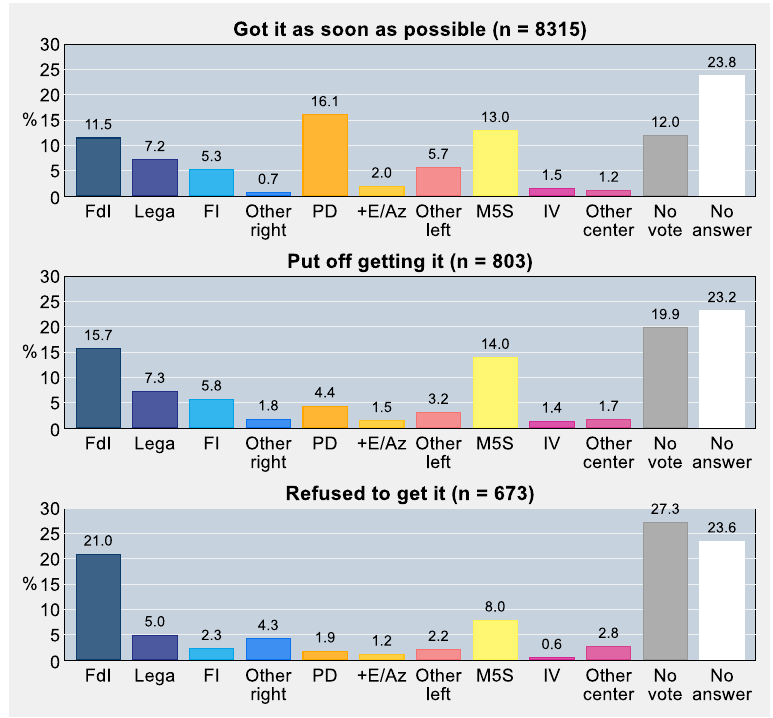
Figure 4. Voting intention as of April/May 2022 by COVID-19 vaccine uptake status. Percentages were post-stratified by using the distribution of Italy’s resident adult population by NUTS region, gender, and age group as of 1 January 2022. Notes: Voting intention among vaccine-exempt individ- uals is not displayed due to small numbers ( n = 209); FdI , Fratelli d’Italia (Brothers of Italy); FI , Forza Italia (Forward Italy); PD , Partito Democratico (Democratic Party); +E , Più Europa (More Europe); Az , Azione (Action); M5S , Movimento 5 Stelle (Five Star Movement); IV , Italia Viva (Italy Alive). Abbrevia- tions: COVID-19, coronavirus disease 2019; NUTS, Nomenclature of Territorial Units for Statistics.